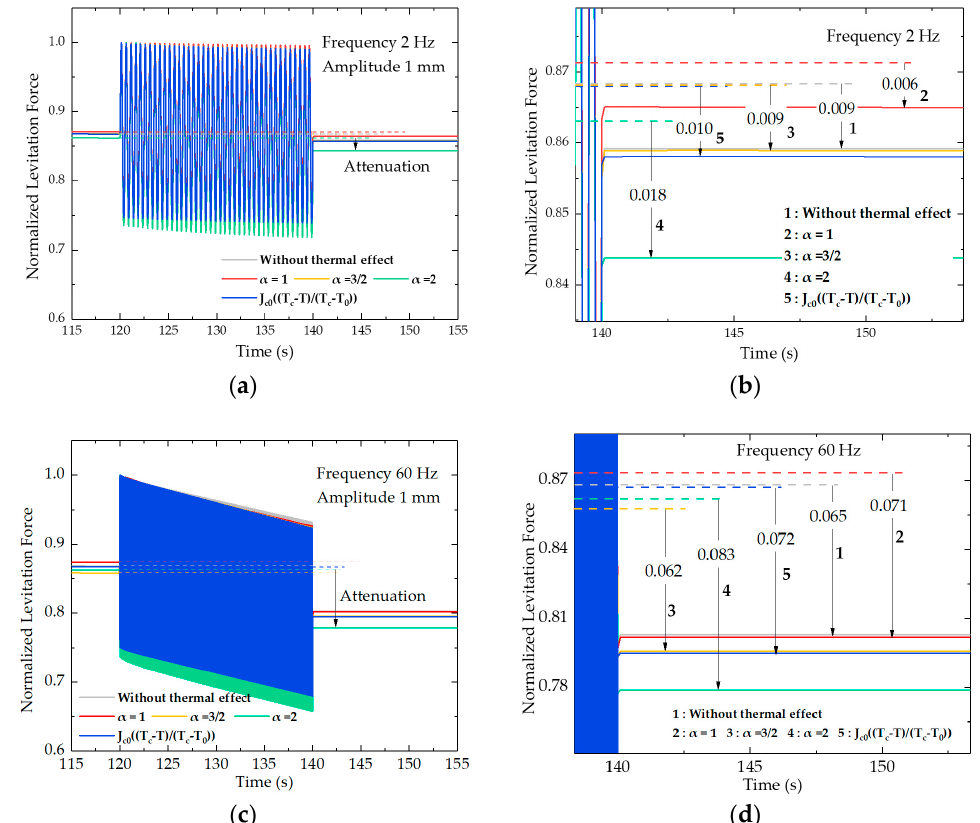
Figure 3. Normalized levitation force profiles by different J c –T relationships of J c = J c0 ; J c = J c1 ( 1- ( T / T c ) 2 ) α , α = 1, 3 / 2, 2; J c = J c0 (( T c -T ) / ( T c -T 0 )) under ( a ) 2 Hz and ( c ) 60 Hz; ( b ) and ( d ) emphasize displaying the force attenuation caused by the vibration process under 2 Hz and 60 Hz, respectively. The dotted lines represent the force value at the end of Relaxation I (120 s). FCH = 30 mm, WH = 15 mm. 1, 2, 3, 4, and 5 represent five J c –T calculation conditions. Table 2. The normalized levitation force attenuation under different J c – T relationships.